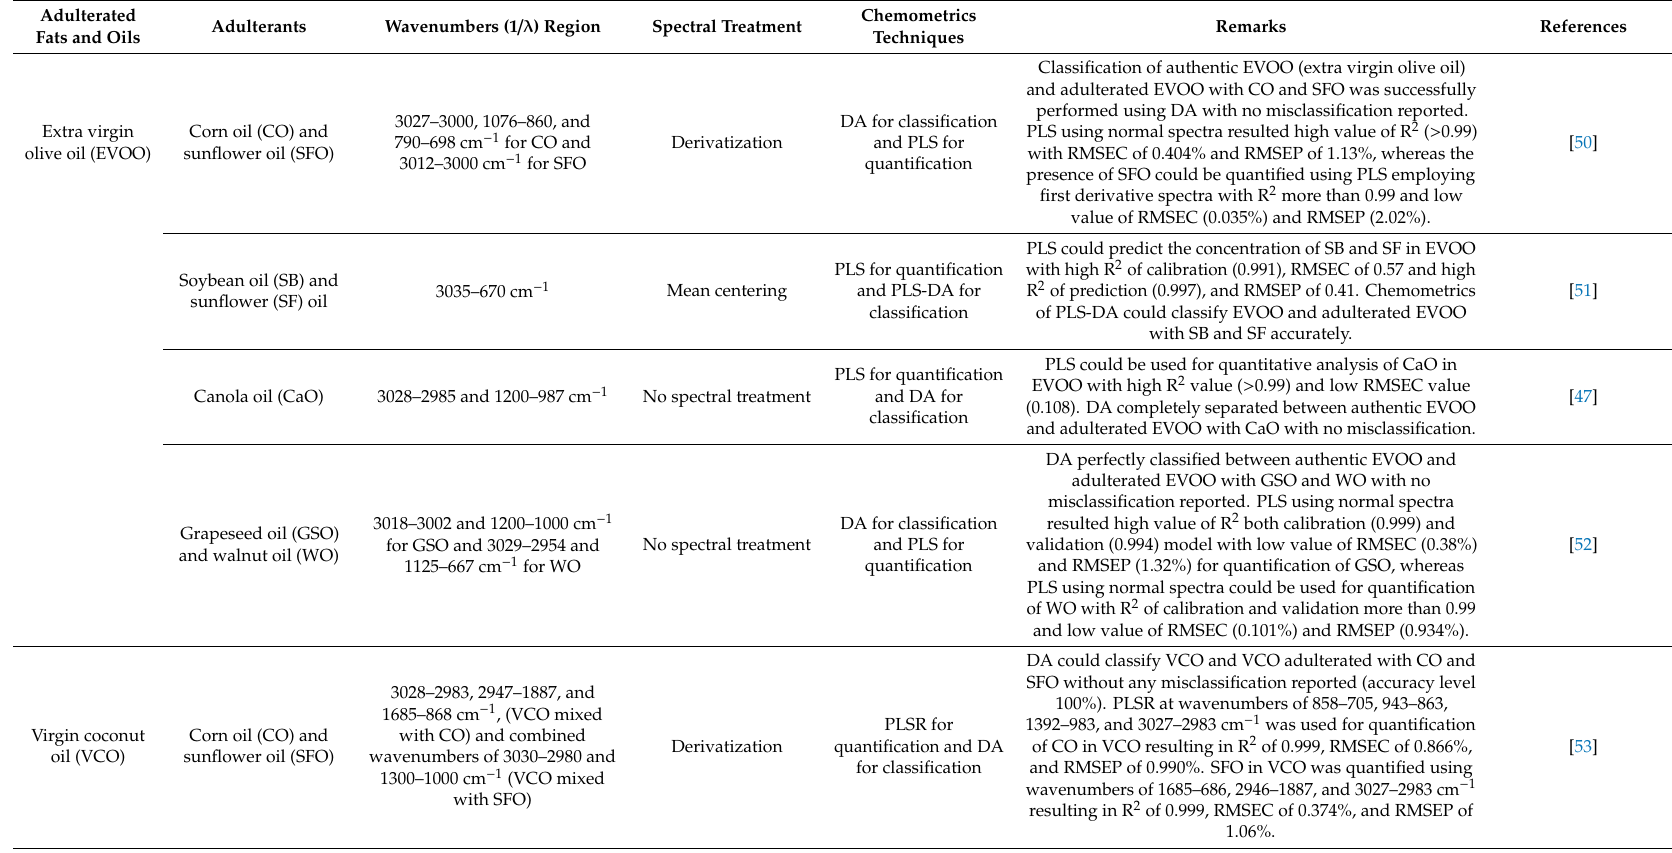
Table 1. The application of FTIR spectroscopy combined with chemometrics for authentication analysis of